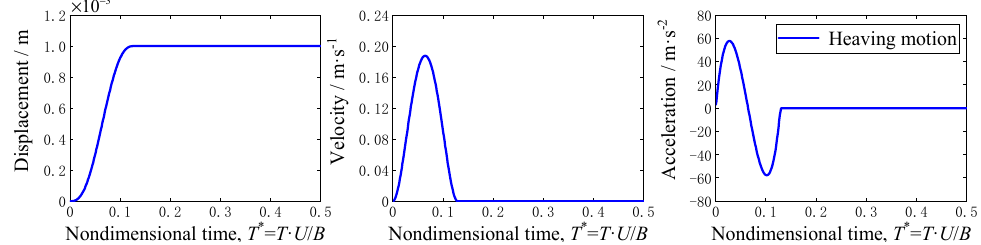
Figure 1. Characteristics of polynomial-basis smoothed-ramped impulse function.